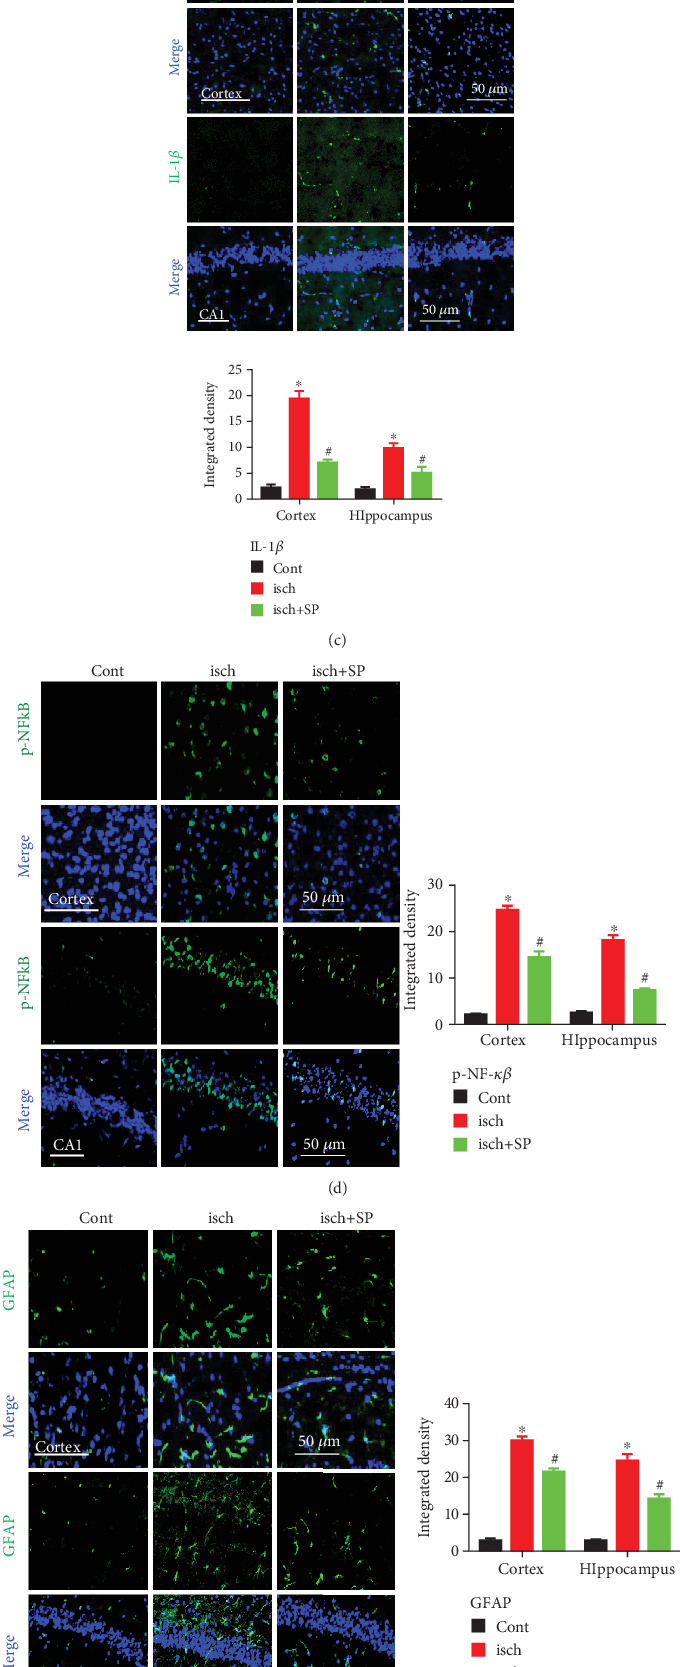
Chronic ischemic condition increases inflammatory responses in ipsilateral cortex and hippocampus of the adult mouse. (a, b) Showing the western blot results of inflammatory mediators. (c-f) Results immunofluorescence results of inflammatory cytokines. P value = P < 0.05, #P < 0.05. Scale bar = 50 μm while magnification was 10x for confocal.